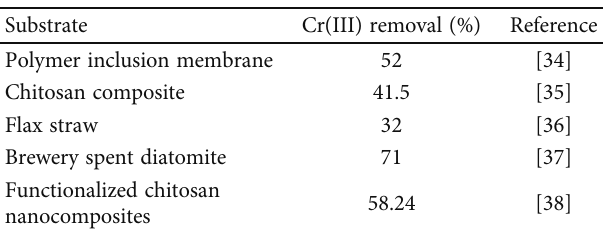
Figure 4: SEM analysis of cellulose-chitosan composite membrane showing the morphology. Table 1: Comparison of Cr removal using di ff erent substrate/